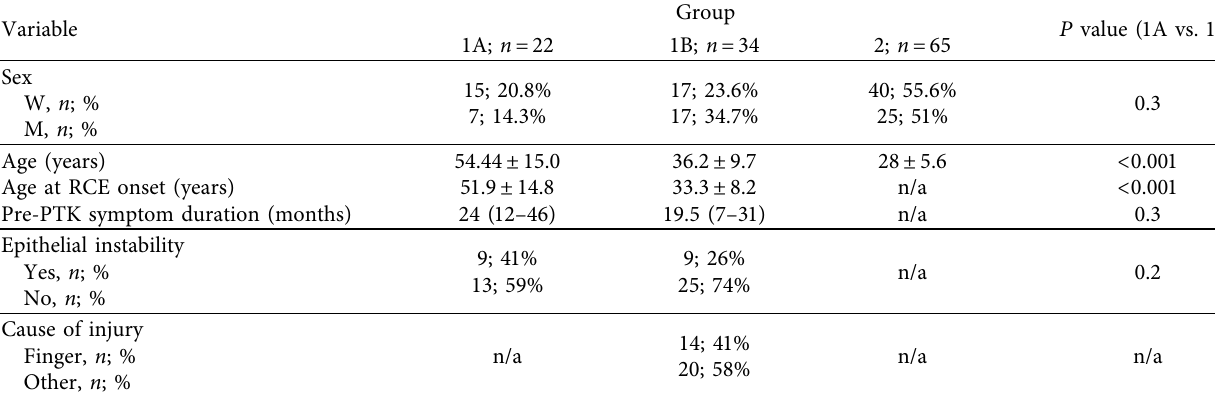
Table 1: Patient characteristics.